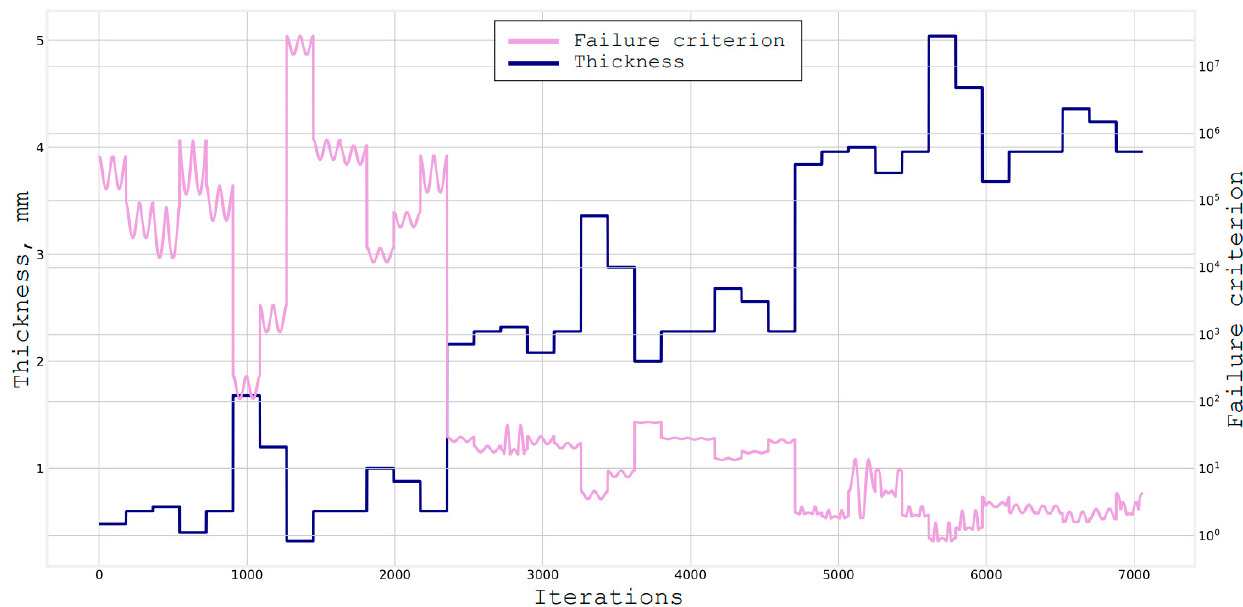
Figure 8. Full search through materials and angles with step of 1°, and a thickness = 5.88 mm 485 s.